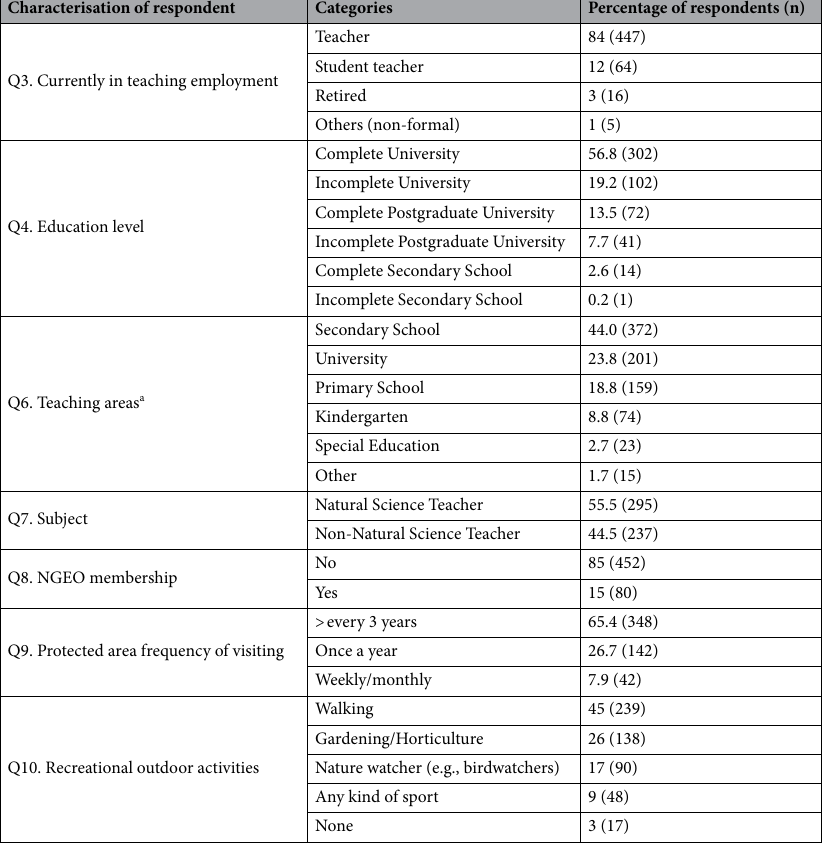
Table 1. Socio-demographic characterisation of respondents. a Some respondents teach in different areas, thus total number of answers (844) is different to the total respondent numbers (532).